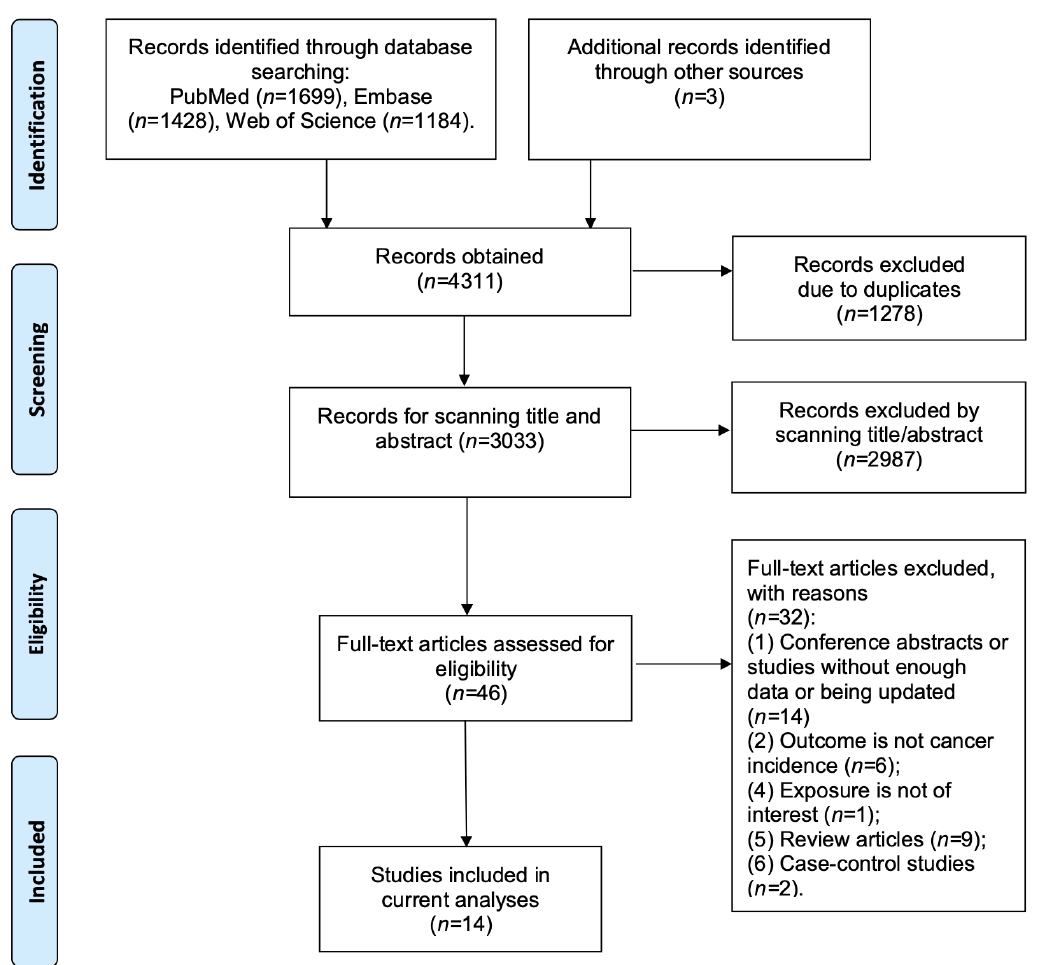
Figure 1. Follow chart of study selection.